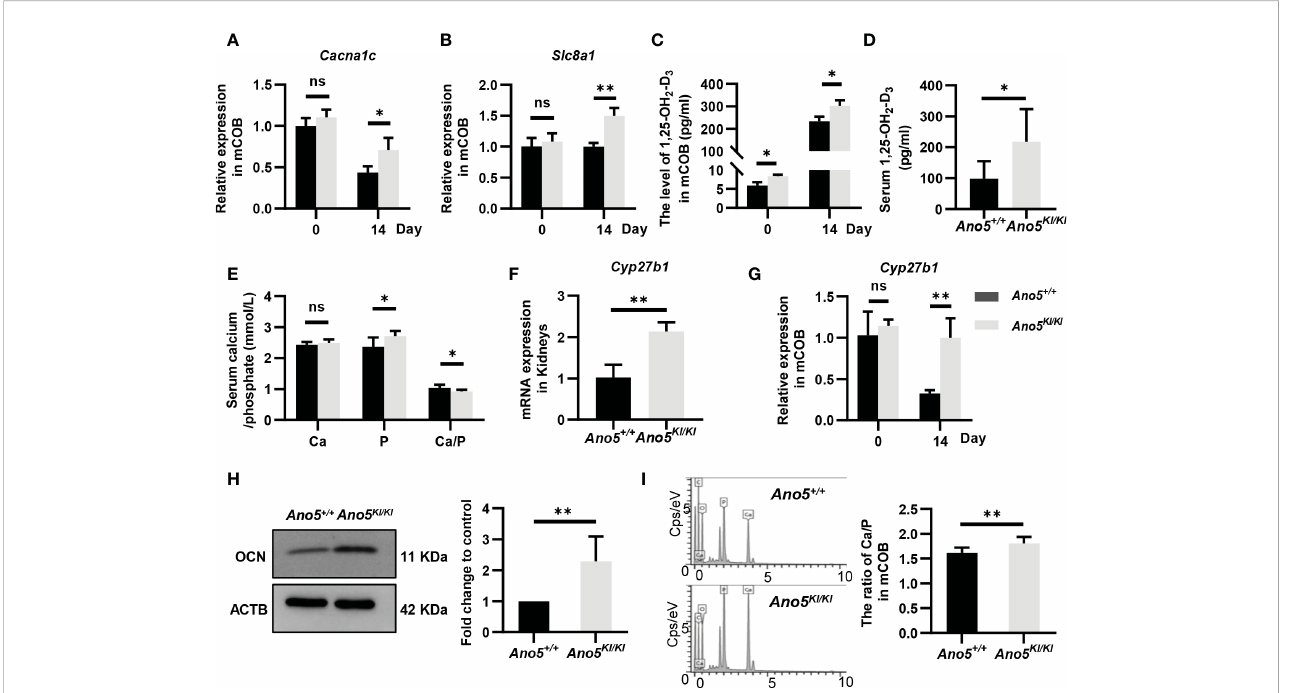
FIGURE 7 Detection of calcium-related genes and calcium content in mineral nodules. (A, B) Relative expression of Cacna1c and Slc8a1 in Ano5 KI/KI mCOBs at days 0 and 14 normalized to levels in Ano5 +/+ cells; (C) Calcitriol levels (pg/ml) were measured by ELISA in intracellular of mCOBs from Ano5 +/+ and Ano5 KI/KI mice at days 0 and 14 after osteogenic induction; (D, E) Serum calcitriol, calcium, phosphate contents in Ano5 +/+ and Ano5 KI/KI male mice (n=10) at 16 weeks of age; (F) qRT-PCR analysis of Cyp27b1 in kidneys of Ano5 +/+ and Ano5 KI/KI male mice (n=4); (G) Relative expression of Cyp27b1 in Ano5 KI/KI mCOBs at days 0 and 14 normalized to levels in Ano5 +/+ cells; (H) Immunoblotting and quantitative analysis of OCN in Ano5 KI/KI compared with Ano5 +/+ mCOBs after 14 days of osteogenic induction; (I) The distribution of elements detected by energy dispersive X-ray spectroscopy and ratio of calcium and phosphate in the mineralized matrix of Ano5 +/+ and Ano5 KI/KI cultures. Data were analyzed using t- tests or one-way ANOVA tests with Dunnett ’ s multiple comparison tests. ns, no signi fi cance; * p < 0.05; ** p <